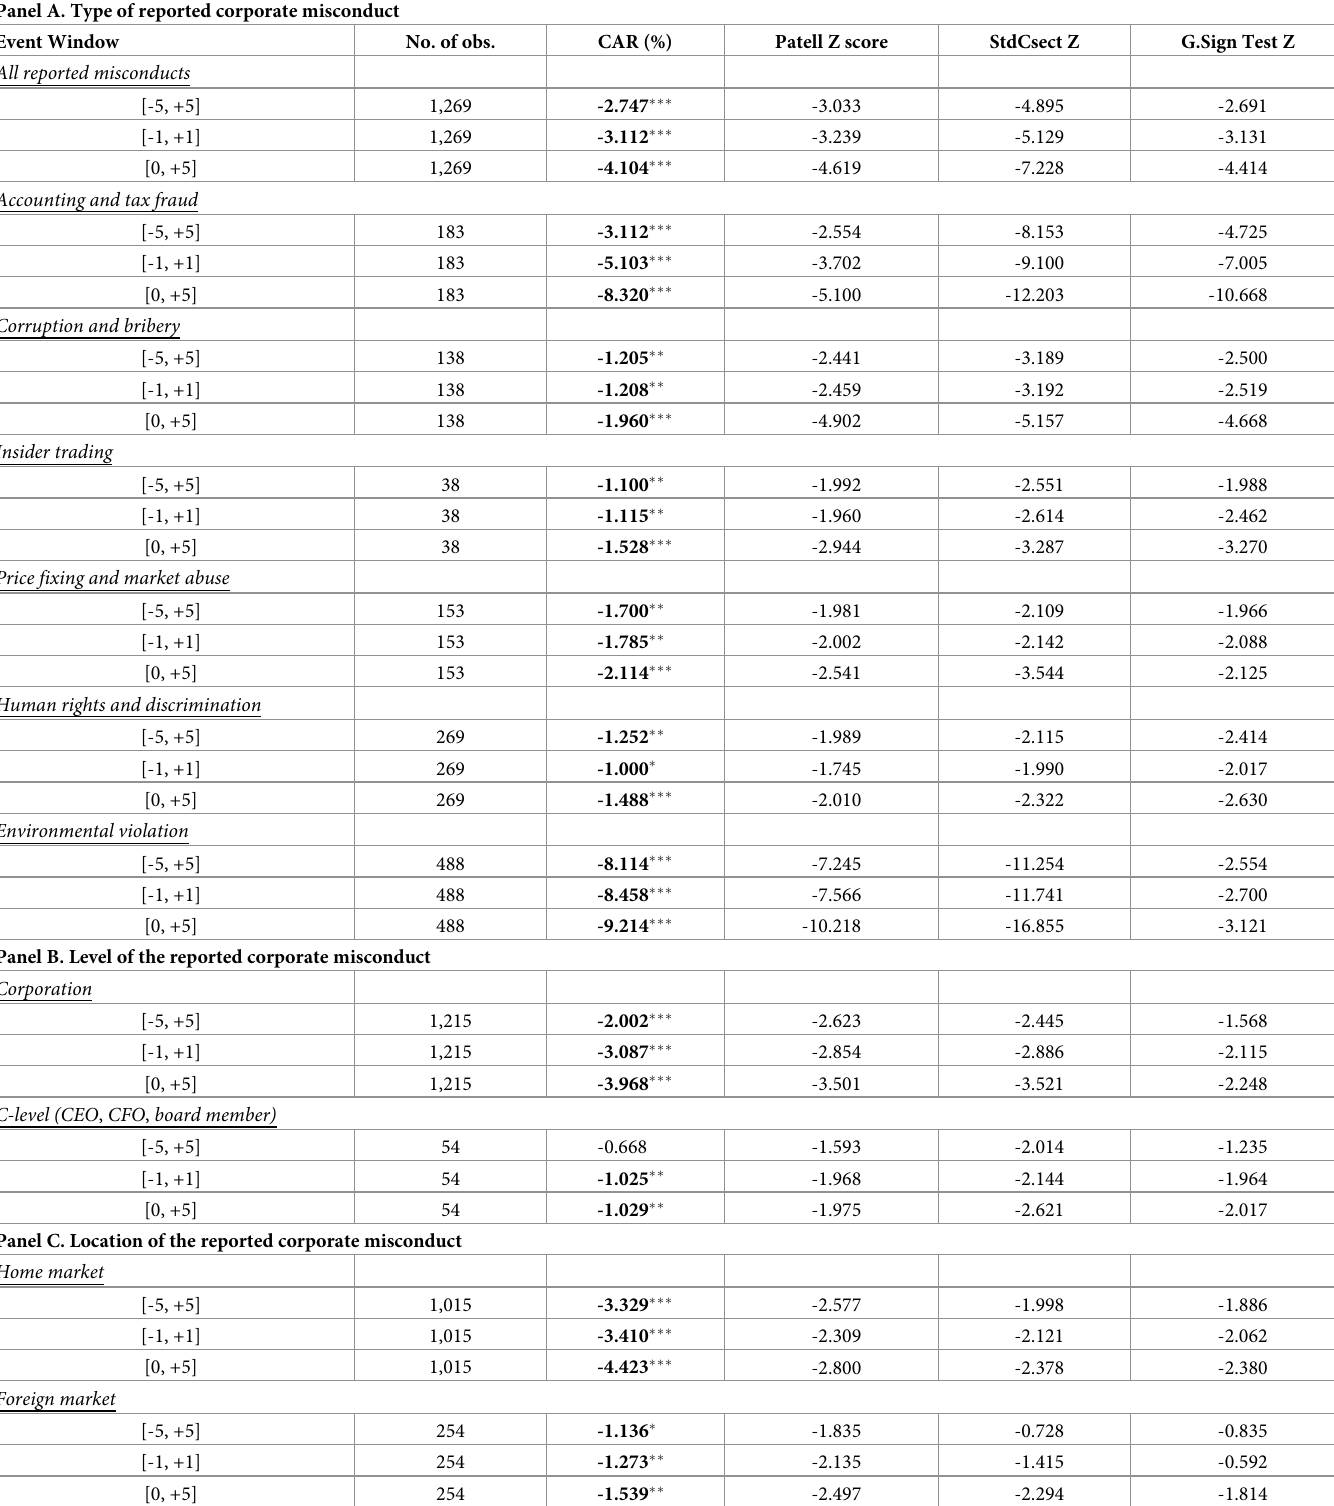
Table 1. Market reaction around the reported corporate misconduct events. Panel A. Type of reported corporate